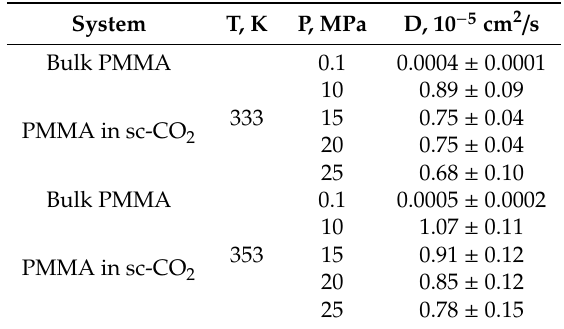
Table 4. Self-di ff usion coe ffi cients of PMMA in bulk and in sc-CO 2 Table 4. Self-diffusion coefficients of PMMA in bulk and in sc-CO 2 .